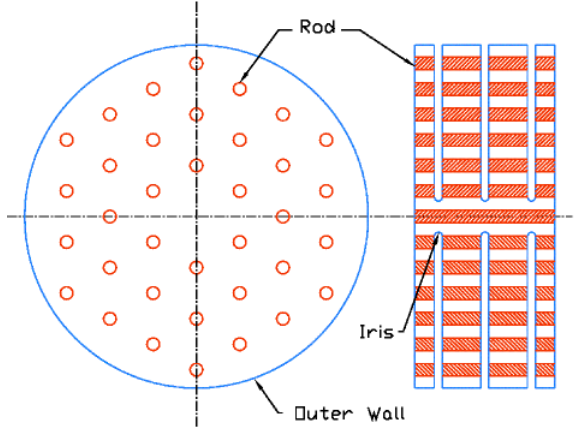
FIG. 6. (Color) The transverse and axial cross sections of the PBG accelerator 2 p (cid:1) 3 structure. The metal rods are set between the disks. The beam holes are formed of the irises in the disks. The iris dimensions are scaled from the SLAC design.